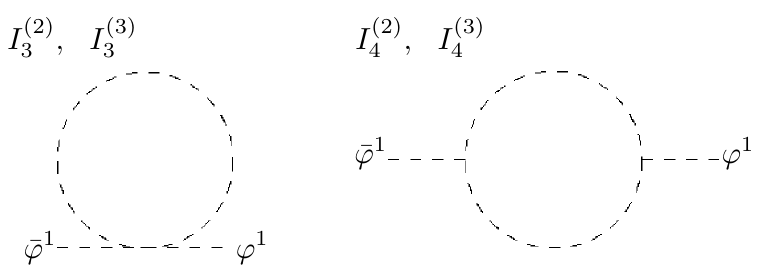
Figure 2 . Scalar loop corrections I (2 , 3)